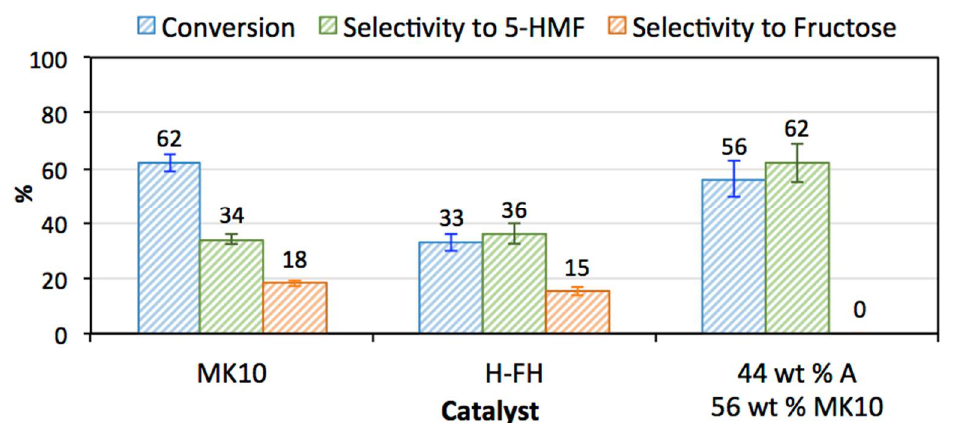
Figure 8. Reproducibility of the catalytic results of the best catalysts. Reaction conditions: 2.4 g of glucose, 0.6 g of catalyst mixture, catalyst/glucose wt ratio = 0.25, solvent volume ratio (THF:H 2 O) = 35:15, temperature = 140 ° C and reaction time = 4 h.